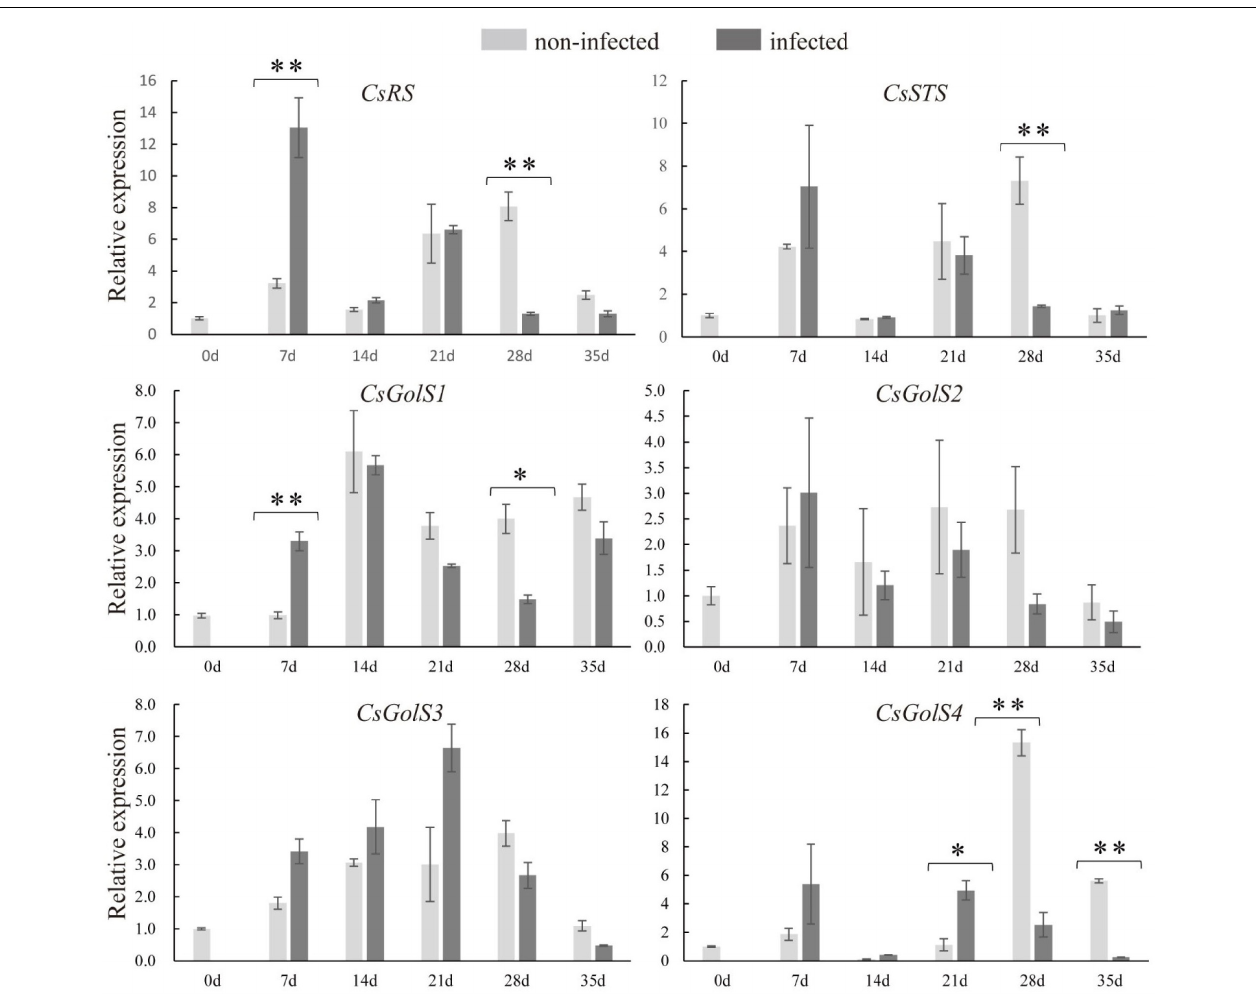
FIGURE 3 | Expression levels of CsRS , CsSTS , CsGolSs in infected and non-infected cucumber roots by M. incognita . CsRS , raffinose synthase gene; CsSTS , stachyose synthase gene; CsGolS1–4 , galactinol synthase genes, respectively. Error bars represent ± SE ( n = 5). Student’s t -test is analyzed between infected and non-infected roots, ∗ P < 0.05; ∗∗ P <